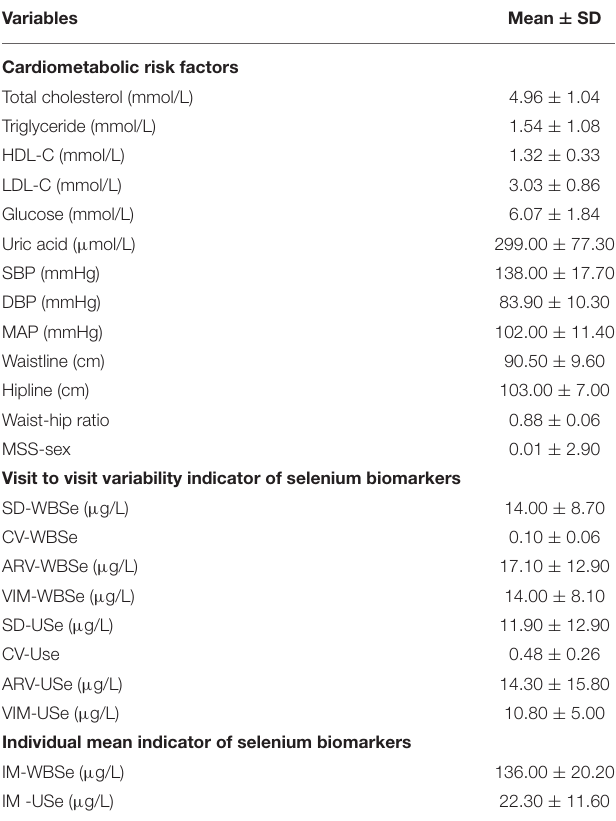
TABLE 3 | Summary of cardiometabolic risk factors and selenium homeostasis of